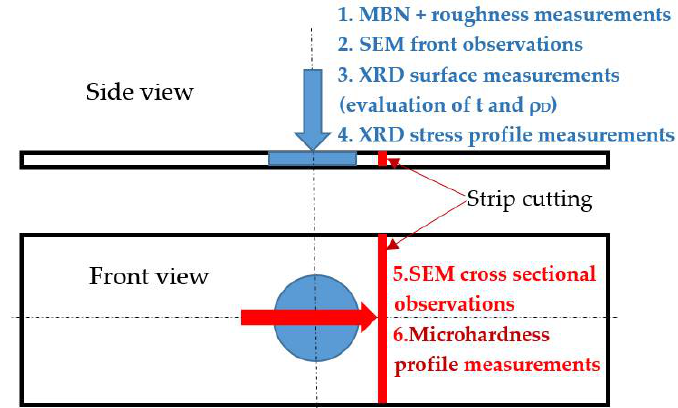
Table 2. Shot peening Figure 1. Evolution of Almen intensities with the shot peening time. Figure 1. Evolution of Almen intensities with the shot peening time.